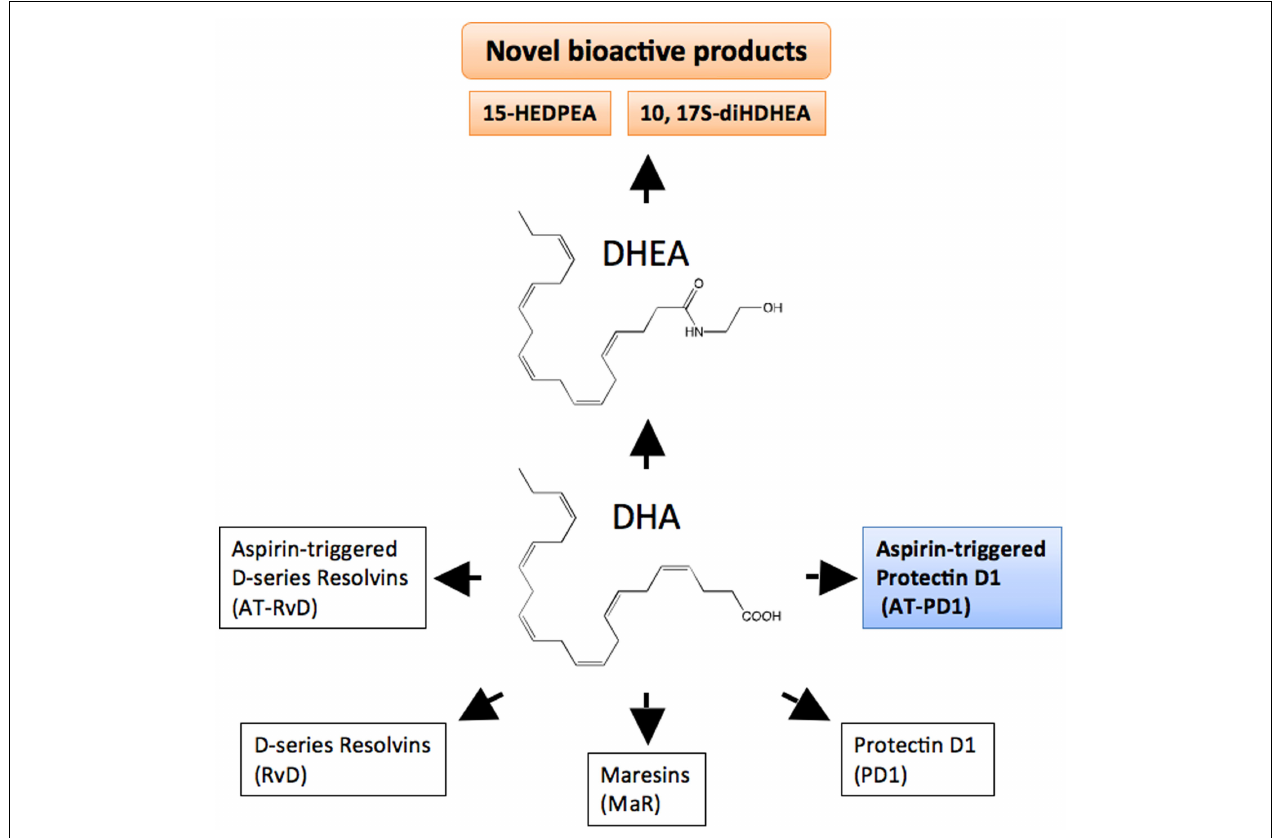
of DHA is conversion to docosahexaenoyl ethanolamide (DHEA). See text for details on the recently identified novel series of bioactive oxygenated DHEA-derived products including 15-HEDPEA and